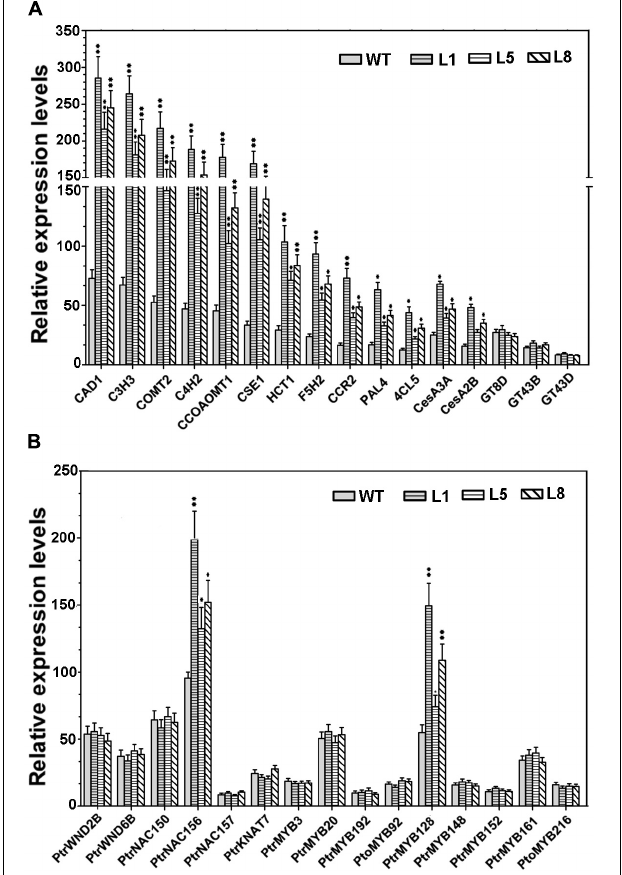
FIGURE 7 | The expression of several secondary wall biosynthetic genes and secondary wall-associated transcription factors in the stems of wild-type and PtoMYB74 overexpression poplar plants by RT-qPCR (after MIQE-guidelines). (A) Key enzyme genes in secondary cell wall biosynthetic pathway. (B) Transcription factors involved in the regulation of secondary cell wall biosynthesis. The poplar 18S rRNA was used as an internal reference. Error bars represent ± SD from three biological repeats. Student’s t -test: ∗ P < 0.05; ∗∗ P < 0.01.